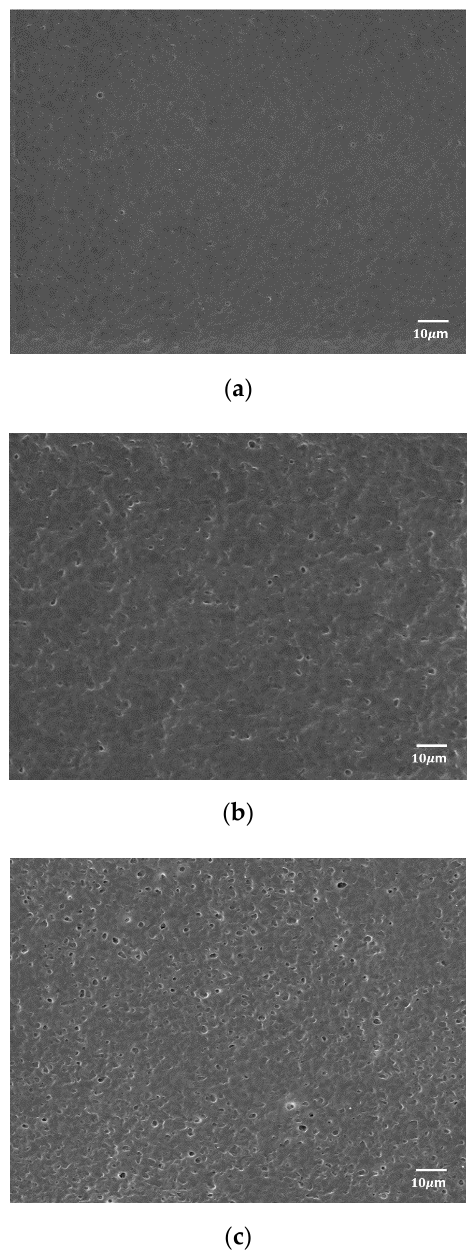
Figure 2. SEM images of ( a ) neat CA, ( b ) 1:0.23 CA/Ni(NO 3 ) 2 ·6H 2 O film dissolved in acetone/water ( wt/wt 8:2) before applying a water pressure treatment and ( c ) 1:0.23 CA/Ni(NO 3 ) 2 ·6H 2 O film dissolved in acetone/water ( wt/wt 8:2) after water treatment at 8 bar.